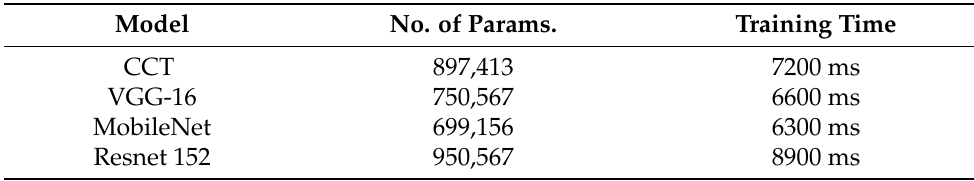
Table 4. Comparison of computational time and number of